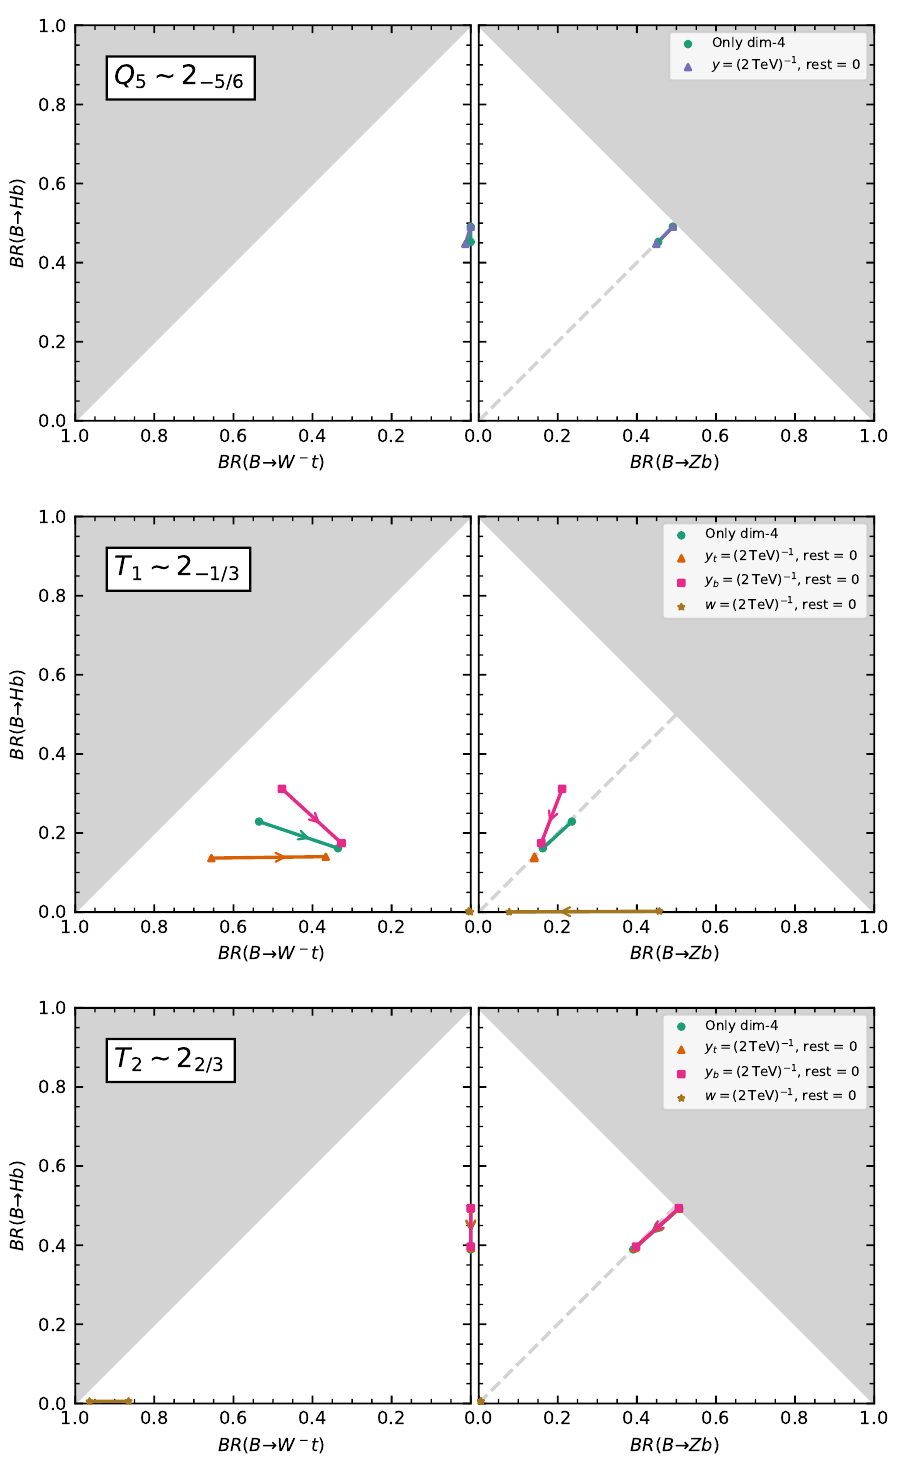
Figure 13 . Branching ratios of B into Hb , Zb and W (cid:0) t for various values of the parameters in the Q 5 , T 2 and T 1 models. The dimensionless couplings (cid:21) are always chosen to saturate the corresponding electroweak precision bounds.